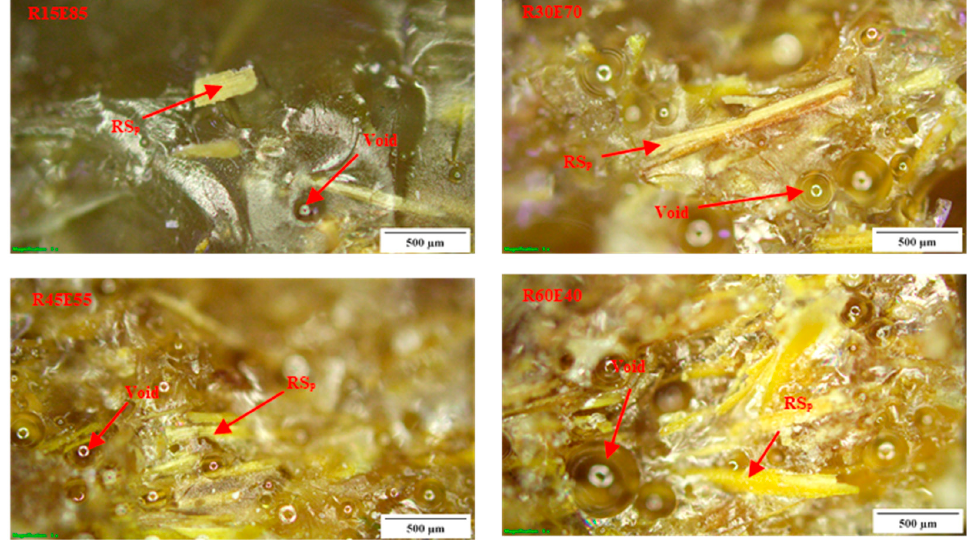
Figure 14. Flexural load-fractured surfaces.